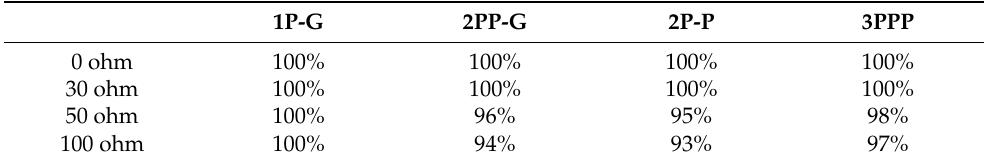
Table 3. Accuracy rates according to fault resistance values.